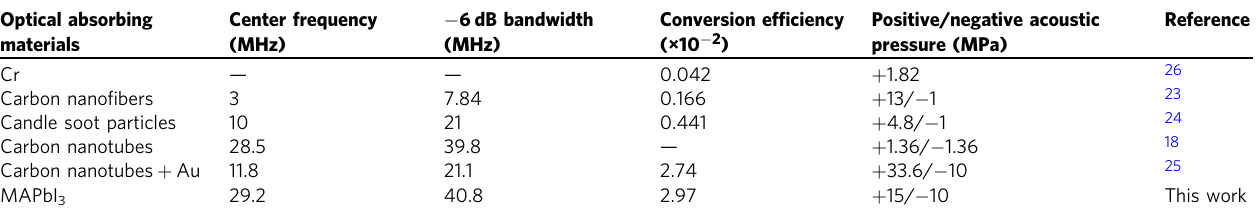
Table 1 Performance summary of representative optoacoustic